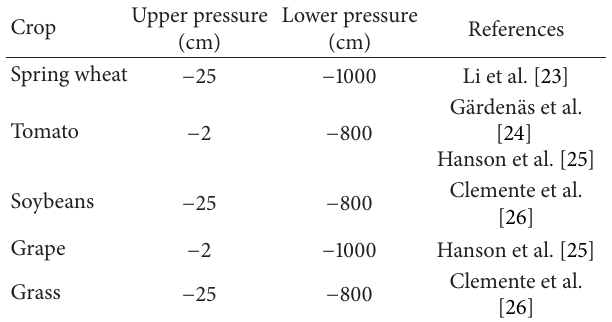
Table 1: Tolerable soil pressure head variations for some